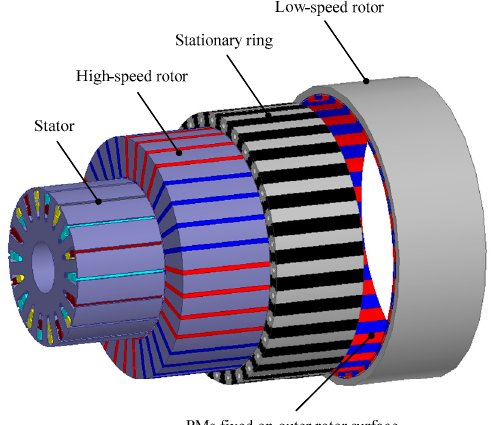
Figure 2. Proposed structure.